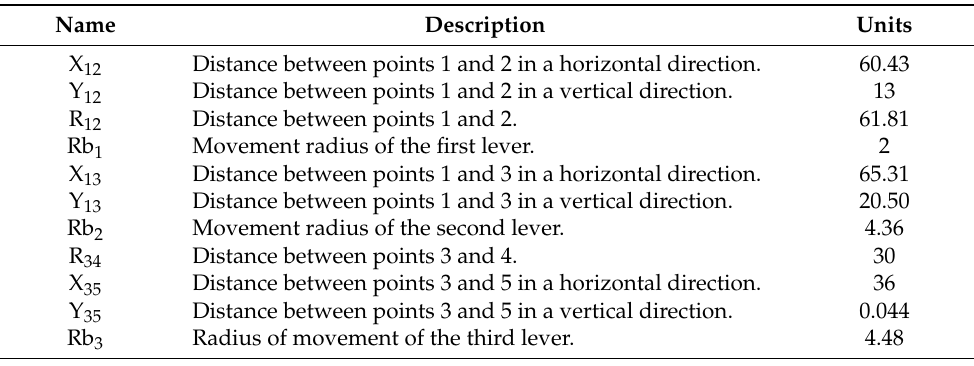
Table 5. Amplification mechanism equations’